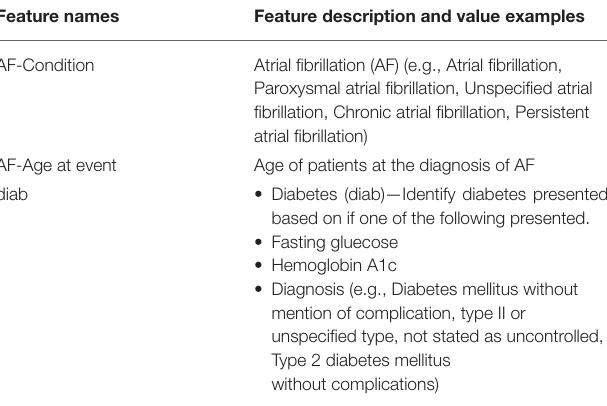
TABLE 1 | Included 27 features and examples of feature